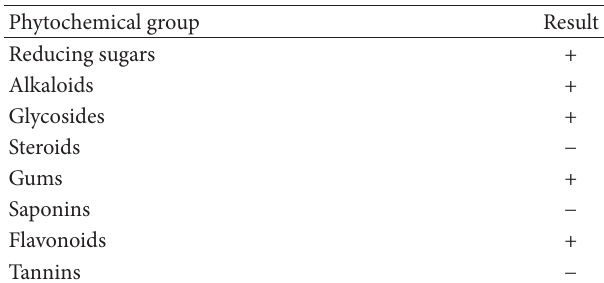
Table 1: Results of phytochemical group test of Z. budrunga seed extract.